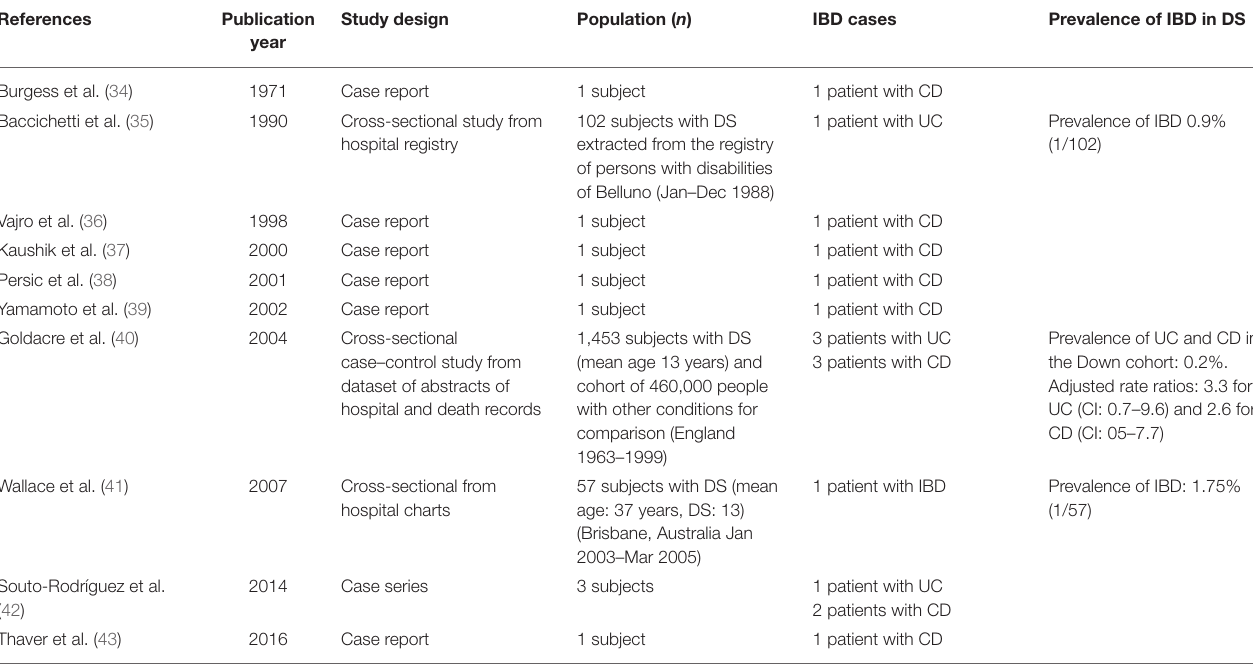
TABLE 3 | Characteristics of published studies reporting cases of IBD in DS